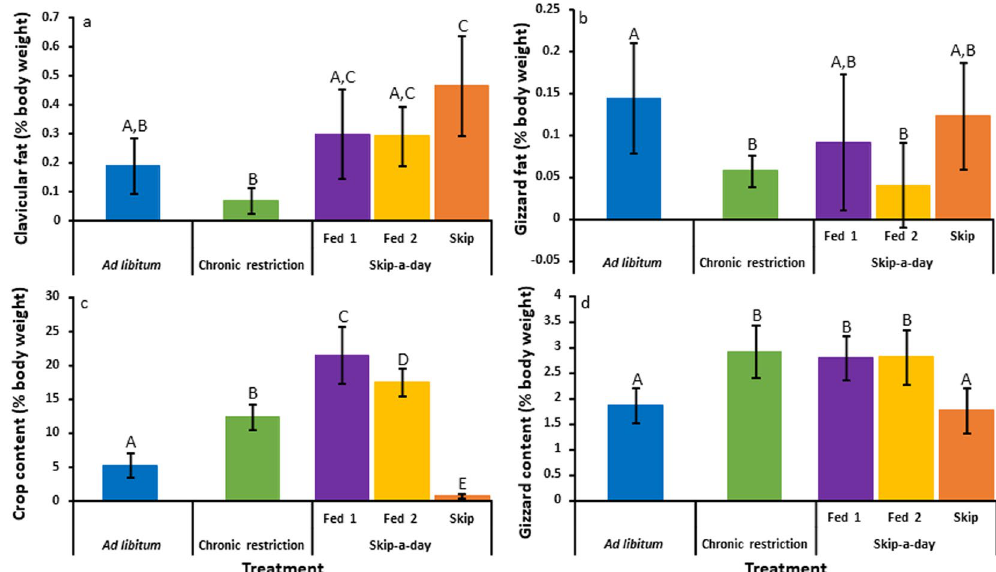
Figure 3. Clavicular fat ( a ), gizzard fat ( b ), crop content ( c ) and gizzard content ( d ) of Red Junglefowl chicks reared under ad libitum feeding (blue, N = 6), chronic feed restriction (Green, N = 6) and skip-a-day feeding consisting of a first fed day, Fed 1 (purple, N = 5) a second fed day, Fed 2 (yellow, N = 4) and a skipped day without food (orange, N = 7). Weights are shown as percentages of body weight. Error bars represent standard deviations of the mean. Significant differences (determined using two-way ANOVA, p < 0.05) are indicated with different